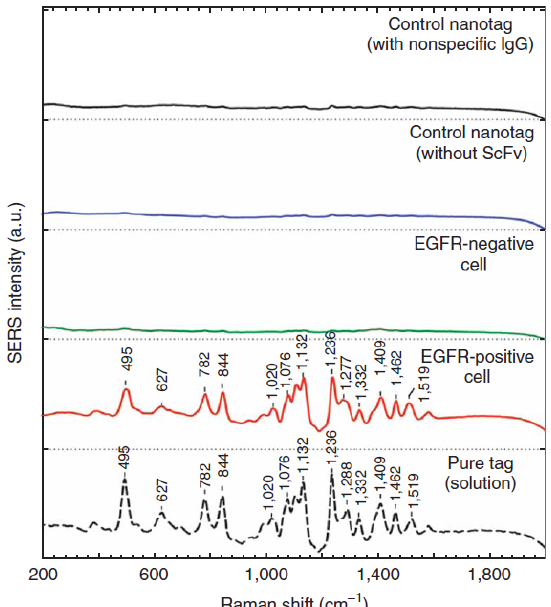
Figure 11. SERS spectra obtained from EGFR-positive cancer cells (Tu686) and from EGFR-negative cancer cells (human non-small cell lung carcinoma NCI-H520), together with control data and the standard tag spectrum. All spectra were taken in cell suspension with 785-nm laser excitation and were corrected by subtracting the spectra of nametag-stained cells by the spectra of unprocessed cells. The Raman reporter molecule is diethylthiatricarbocyanine (DTTC), and its distinct spectral signatures are indicated by wavenumbers (cm –1 ). © 2010 Nature Publishing